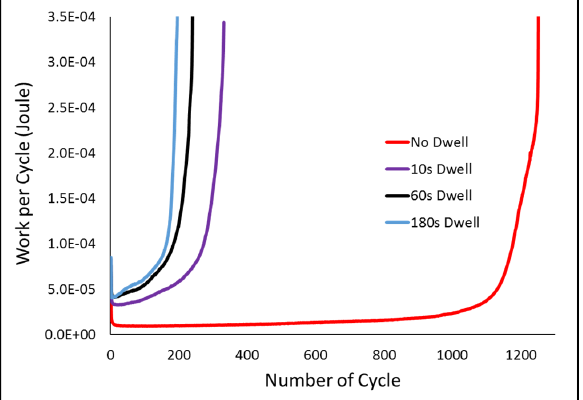
Figure 21. Inelastic work vs. the number of cycles for SAC305 solder joints cycled at 20 MPa stress amplitudes at various dwellings until failure.